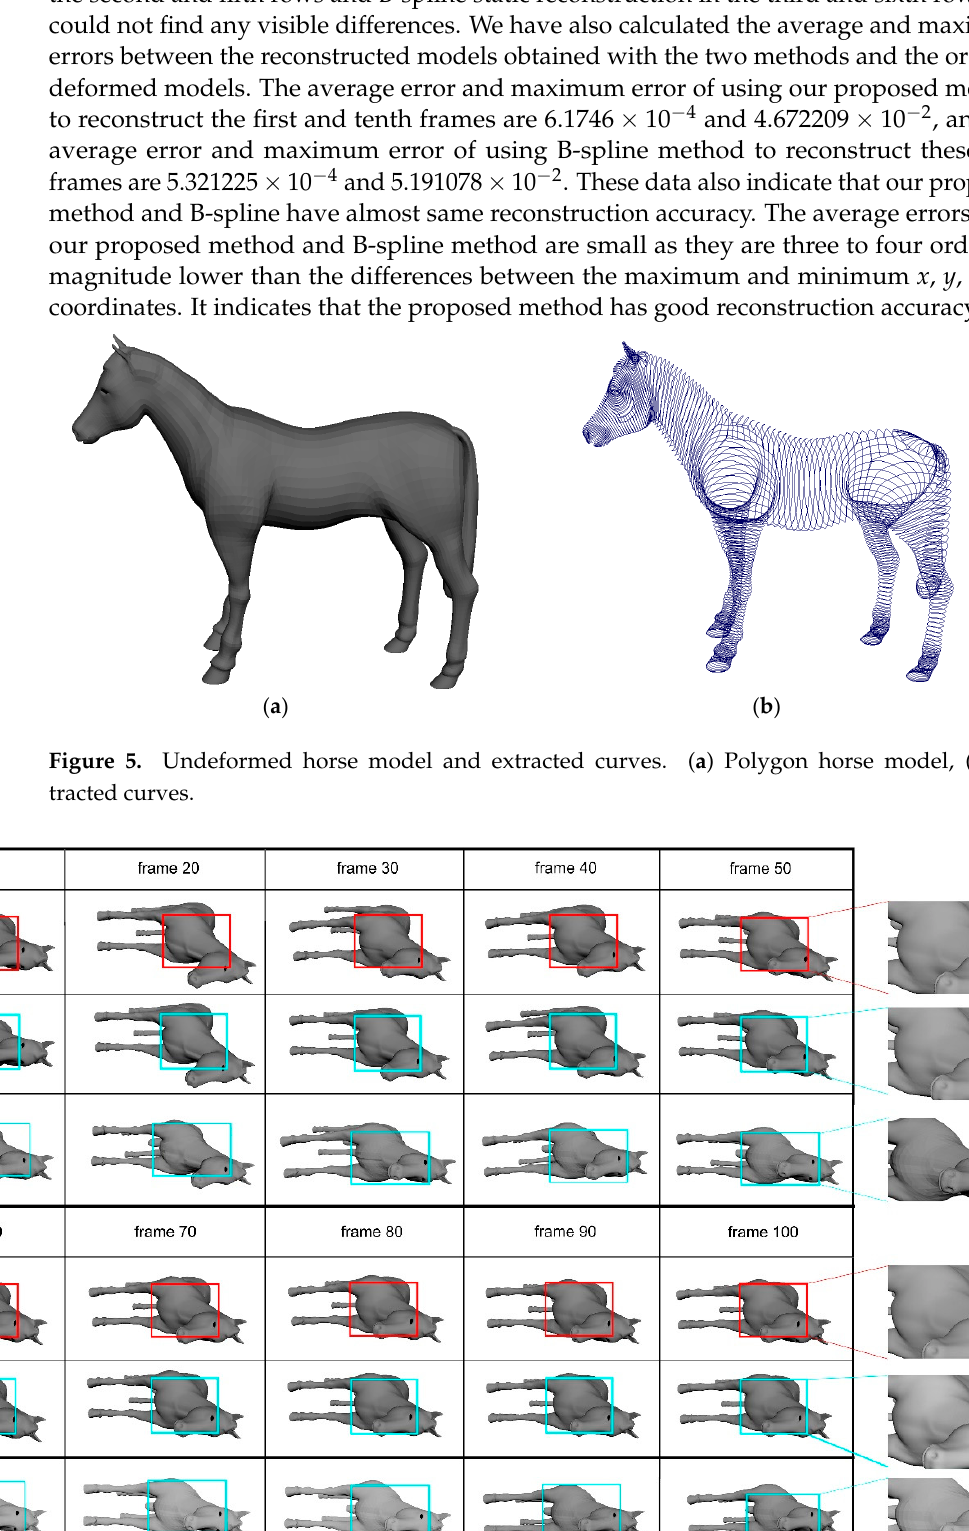
17 of 25 Table 3. Design variables, errors ( × 10 (cid:2879)(cid:2872) ), and computational time (CPU) for reconstruction shown in Figure 4. PM